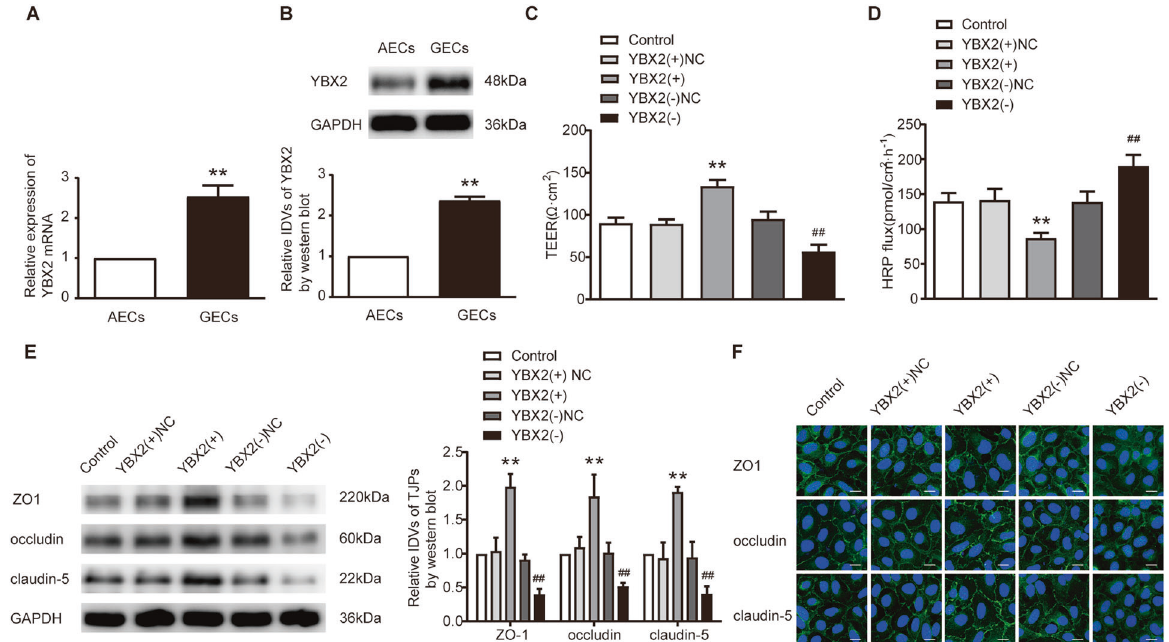
Fig. 2 Knockdown of YBX2 increased BTB permeability in vitro. A, B The mRNA and protein expression of YBX2 in AECs and GECs were detected by qRT-PCR and western blot. Data represent mean ± SD ( n = 3, each). ** P < 0.01 vs. AECs group. C , D Effects of YBX2 on TEER value and HRP fl ux. Data represent mean ± SD ( n = 3, each). ** P < 0.01 vs. YBX2( + )NC group, ## P < 0.01 vs. YBX2 (-)NC group. E Effects of YBX2 on the expression levels of ZO-1, occludin and claudin-5 determined by western blot. Data represent mean ± SD ( n = 3, each). ** P < 0.01 vs. YBX2( + ) NC group, ## P < 0.01 vs. YBX2 (-)NC group. F Effects of YBX2 on ZO-1, occludin and claudin-5 expression levels and distribution determined by immuno fl uorescence. Scale bar represents 30 μ